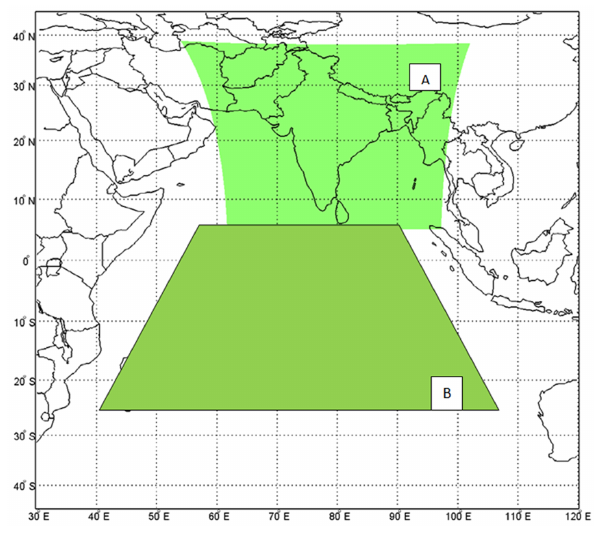
Figure 1. INSAT-3D sounder scan processing strategy over land and ocean.